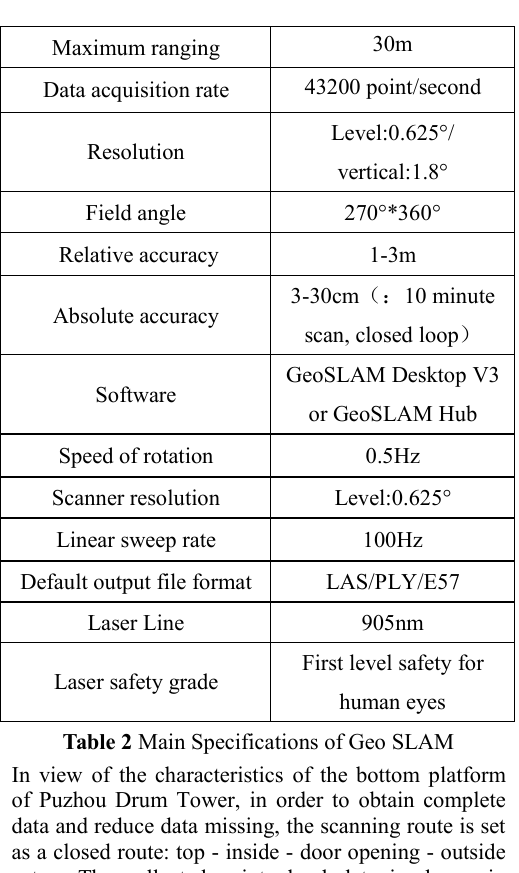
Figure 4. SLAM 3D Laser Scanning